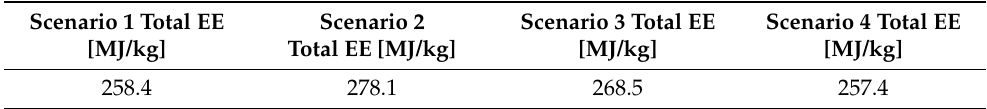
Table 4. Total EE values for each